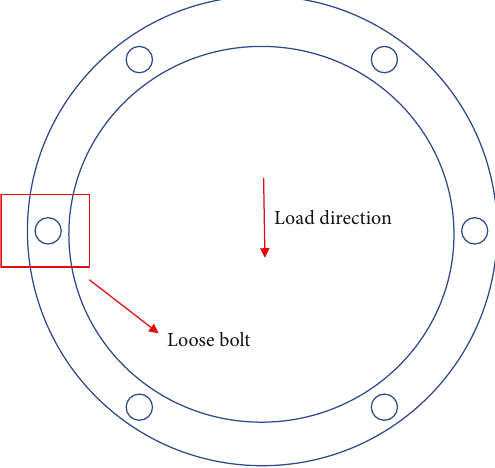
Figure 27: Schematic diagram of bolts arrangement in Table 6.